Question: Write a single sentence explaining what this figure depicts.
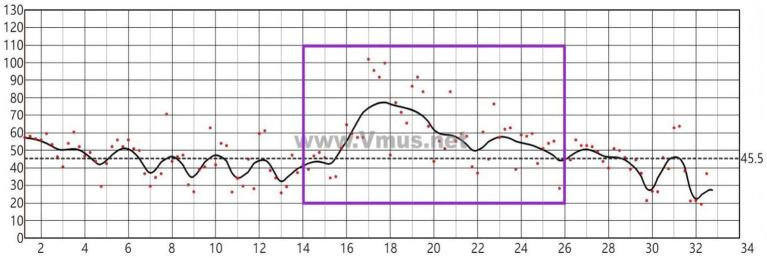
Answer: Jean-Yves Thibaudet Macro Tempo Curve.